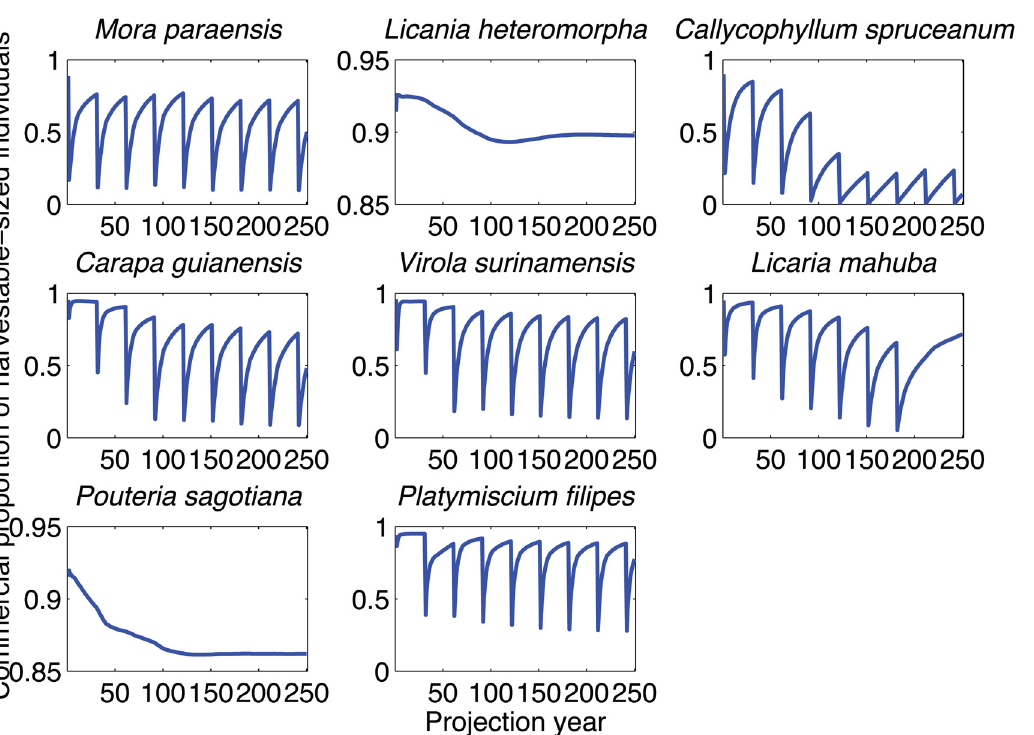
Fig 2. Shifts in merchantable proportion under the 30 yr Brazilian legal management regime but without volume-based harvest limits. Licania heteromorpha and P . sagotiana were not harvested during simulations.